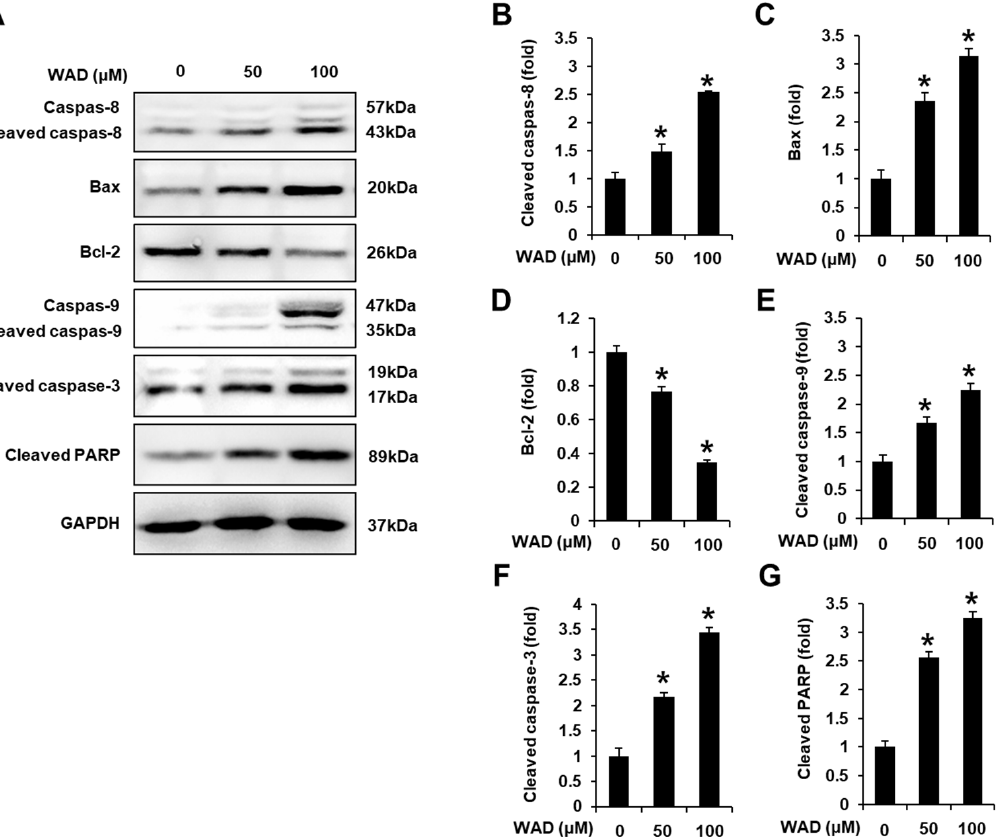
Figure 8. Effects of withagenin A diglucoside (WAD) ( 3 ) on apoptosis signaling pathways in human hepatocellular carcinoma (HepG2) cells. HepG2 cells were treated with WAD (50 and 100 µ M) for 24 h. Cells were treated with culture media containing 0.5% DMSO as vehicle controls: ( A ) Protein expression levels of cleaved caspase-8, Bcl-2-associated X protein (Bax), B-cell lymphoma 2 (Bcl-2), cleaved caspase-9, cleaved caspase-3, cleaved poly(ADP-ribose) polymerase (cleaved PARP), and glyceraldehyde-3-phosphate dehydrogenase (GAPDH). ( B – G ) Each bar graph presents the densito- metric quantification of protein expression levels. Data are presented as the mean ± standard error of the mean (SEM). n = 3, * p < 0.05 compared with the